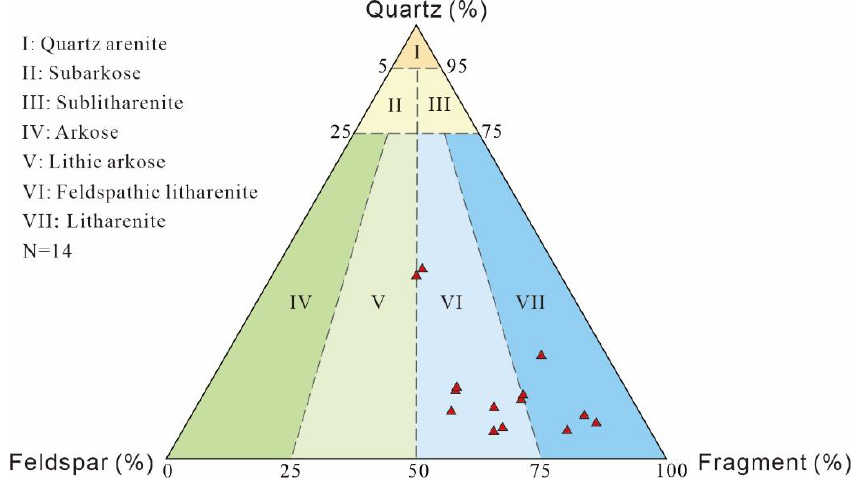
Figure 3. Mineral content of clastic rocks of the Jiucaiyuan Formation in the Beisantai Uplift.